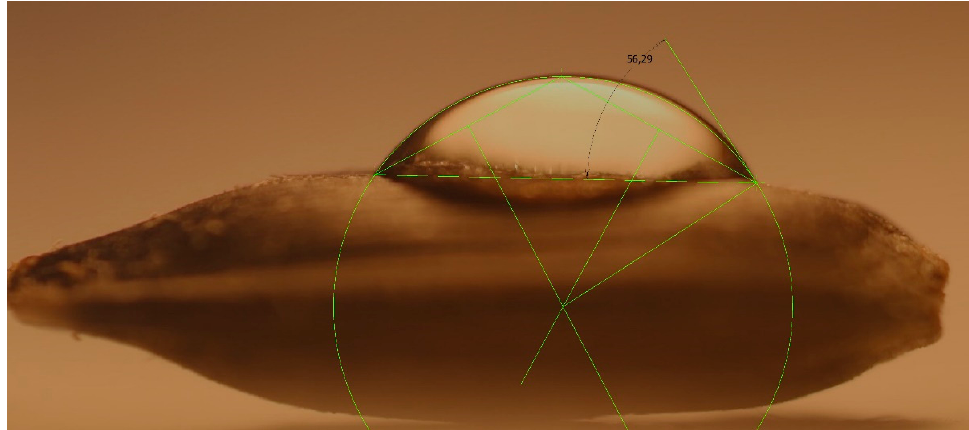
Figure 1. Water droplet on the sunflower seed surface and its evaluation by Autodesk Inventor 2018 software.